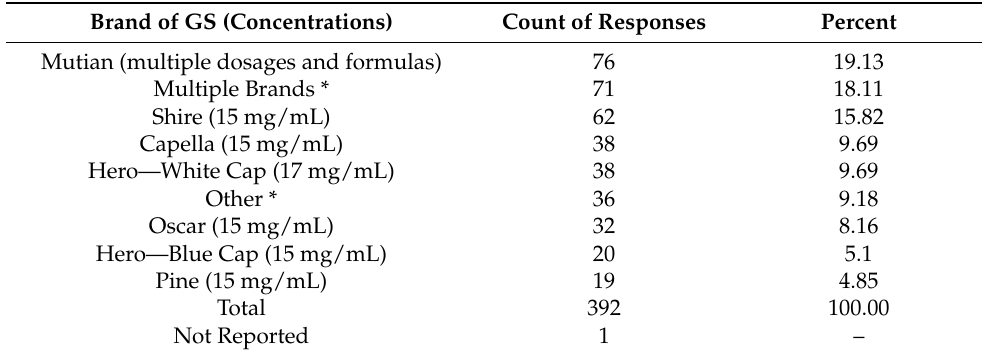
Table 5. Brand of GS-441524 reported. Many respondents used more than one brand during